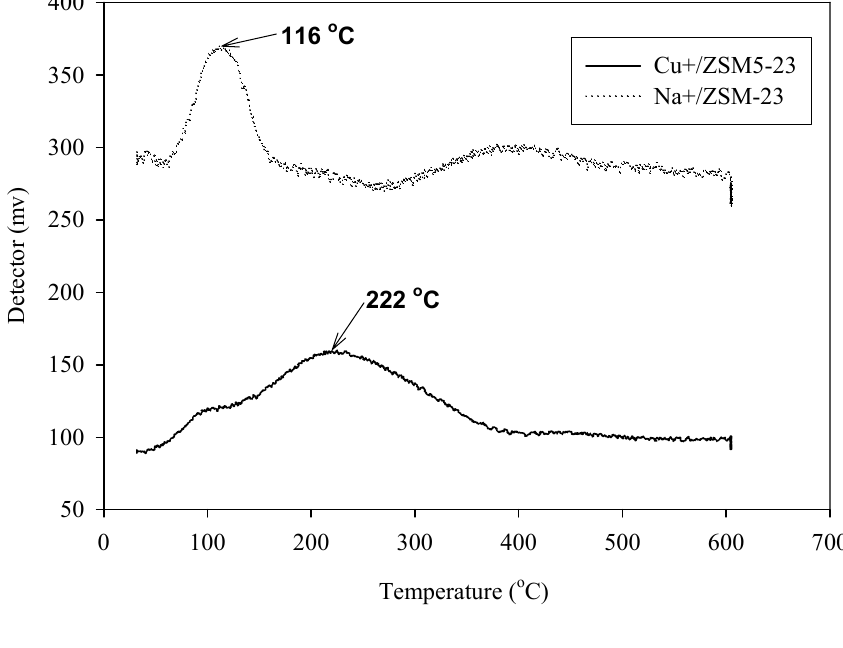
Figure 4. TPD spectra of Na-ZSM5 and Cu-ZSM5 exposed to CO at 298 K and 1